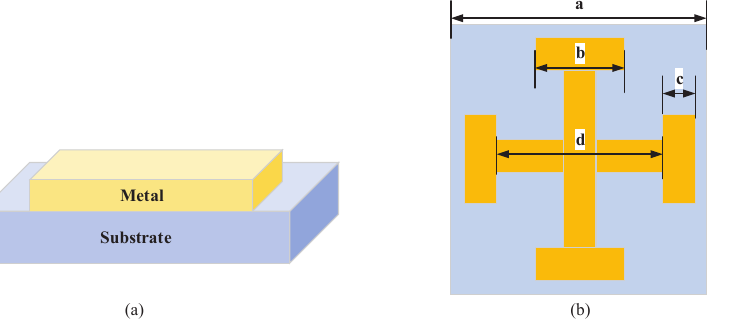
Figure 2. Schematic diagram of the two-layer metasurface lens. ( a ) The copper layer is patterned on a RO4003C PCB substrate. ( b ) Schematics diagram of the unit cell of the designed structure. Table 1. Dimensions of the phase-shift